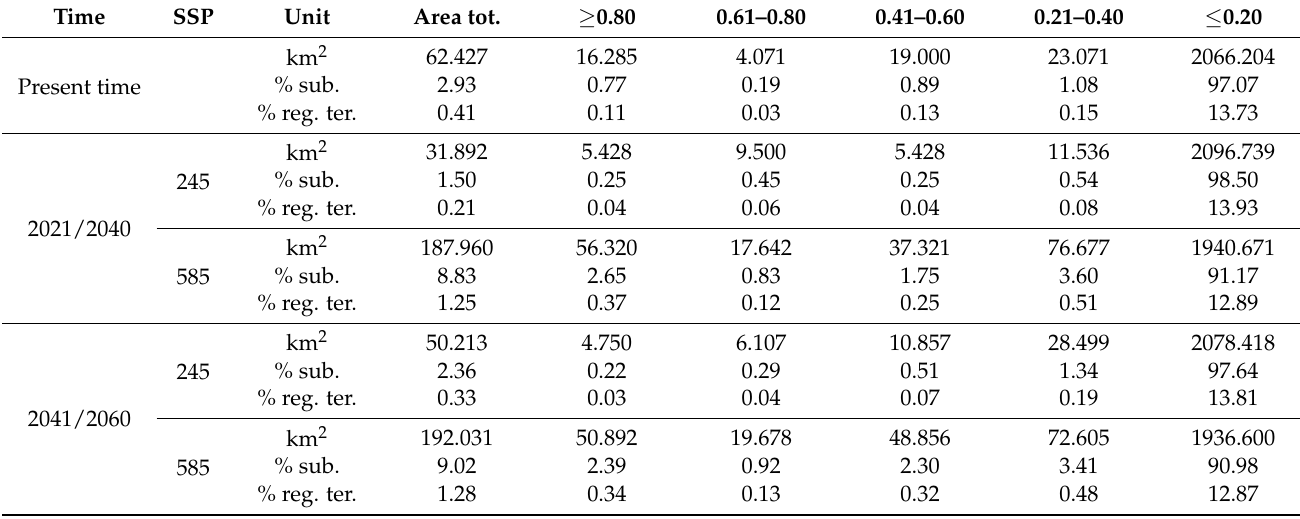
Table 4. Classification of habitat suitability related to the probability values for the presence of the Salvia ceratophylloides Ard. in areas with sandy substrate and conglomerates in the Calabria Region. [highly unsuitable ( ≤ 0.20); unsuitable (0.21–0.40); moderately suitable (0.41–0.60); highly suitable (0.61–0.80); very highly suitable ( ≥ 0.80); area (km 2 ), and the relative percentage in relation to the geological substratum (% sub.) and percentage in relation to the entire regional territory (% reg.